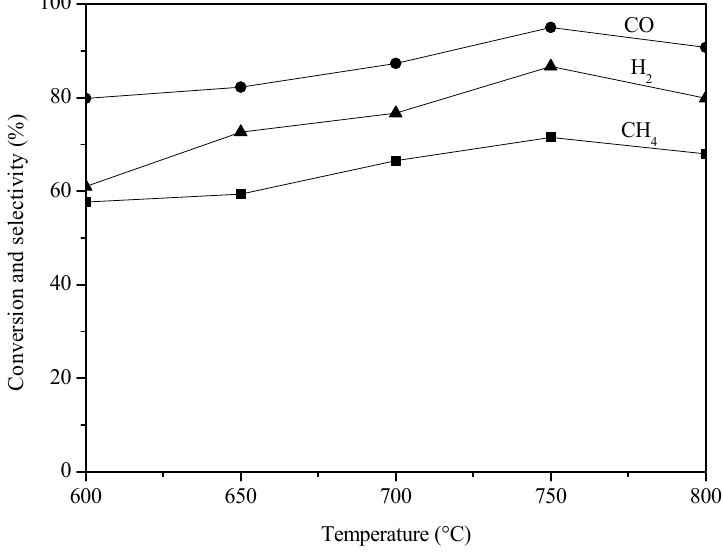
Figure 2. Catalytic performance of Pd/Al different